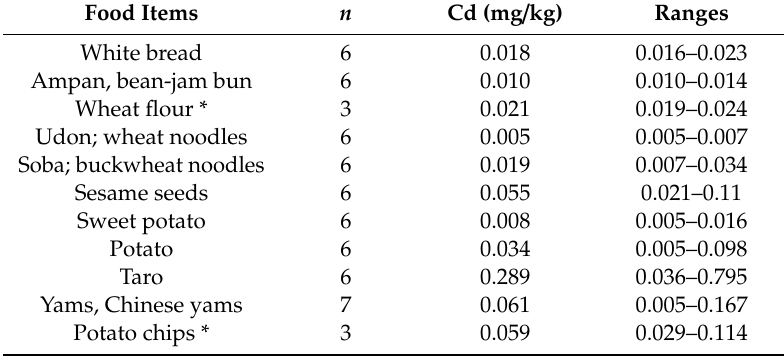
Table 2. Cadmium (Cd) concentrations in cereals, tubers, and roots. Data are presented as arithmetic means.